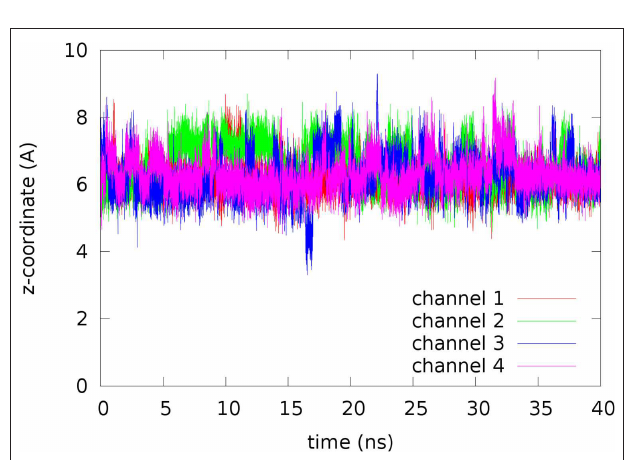
FIGURE 3 | Fluctuations of glycerol inside the channel. The coordinates represent the last 40 ns of the 120 ns MD run.